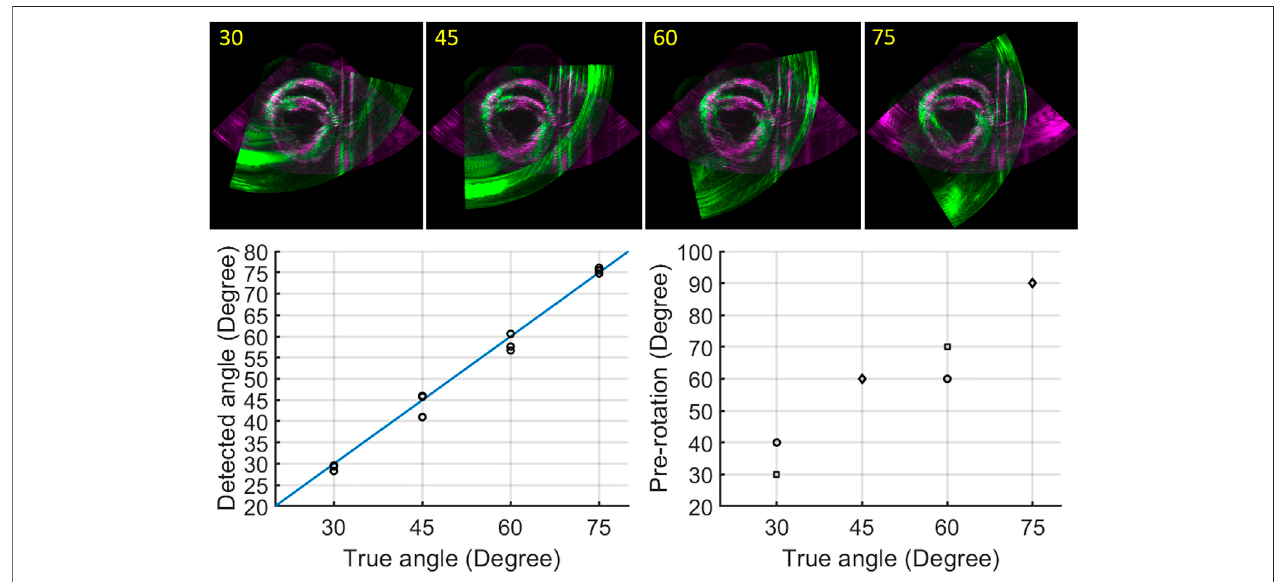
FIGURE 6 | Registration results: registered image data for angles ranging from 30 ° to 75 ° ( top row ); true angle versus detected angles, black circles indicate three different cardiac cycles ( bottom left ); true angle versus pre-rotation angles (circle: one cardiac cycle, square: two cardiac cycles, diamond: three cardiac cycles) ( bottom right